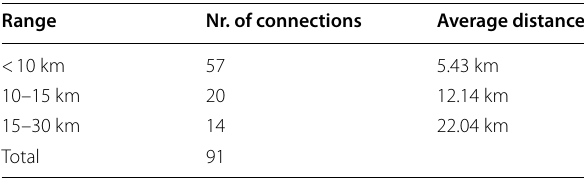
Table 3 Connections between urban centres provided by the cycle network in the range 0–30 km